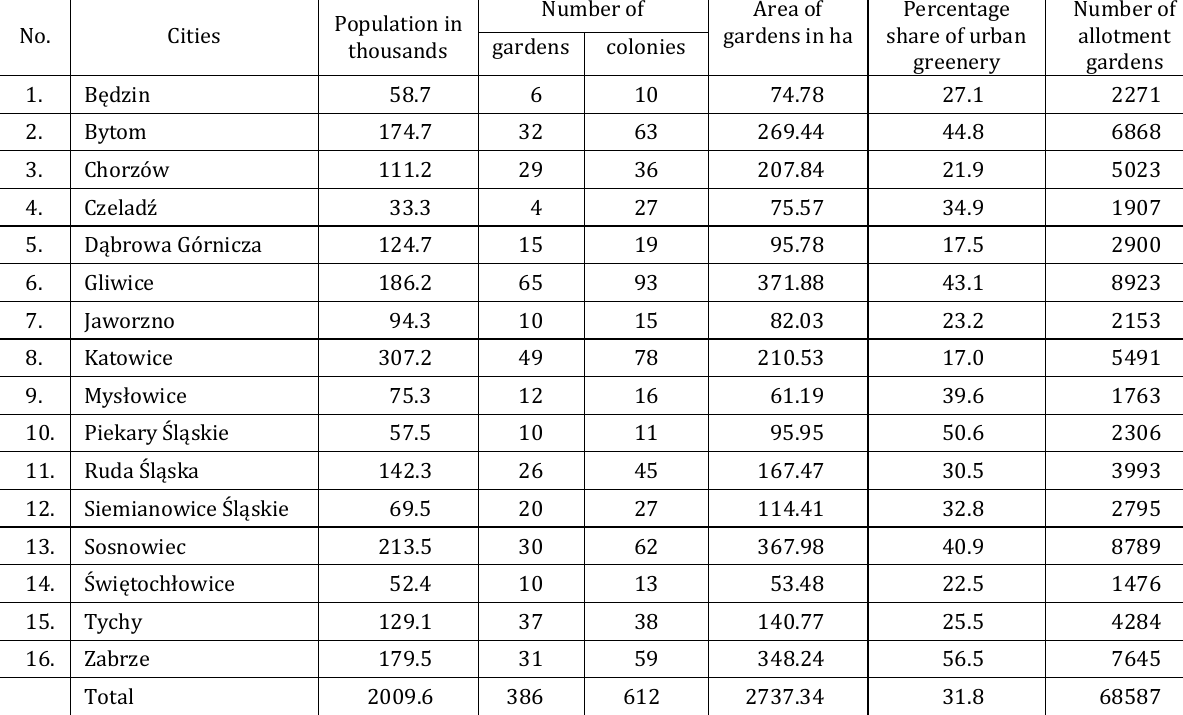
Table 1. Allotment gardens in the Katowice conurbation in 2012 (after Registration Cards for Employee Allotment Gardens in the Silesian District Board of the Polish Association of Allotments in Katowice)